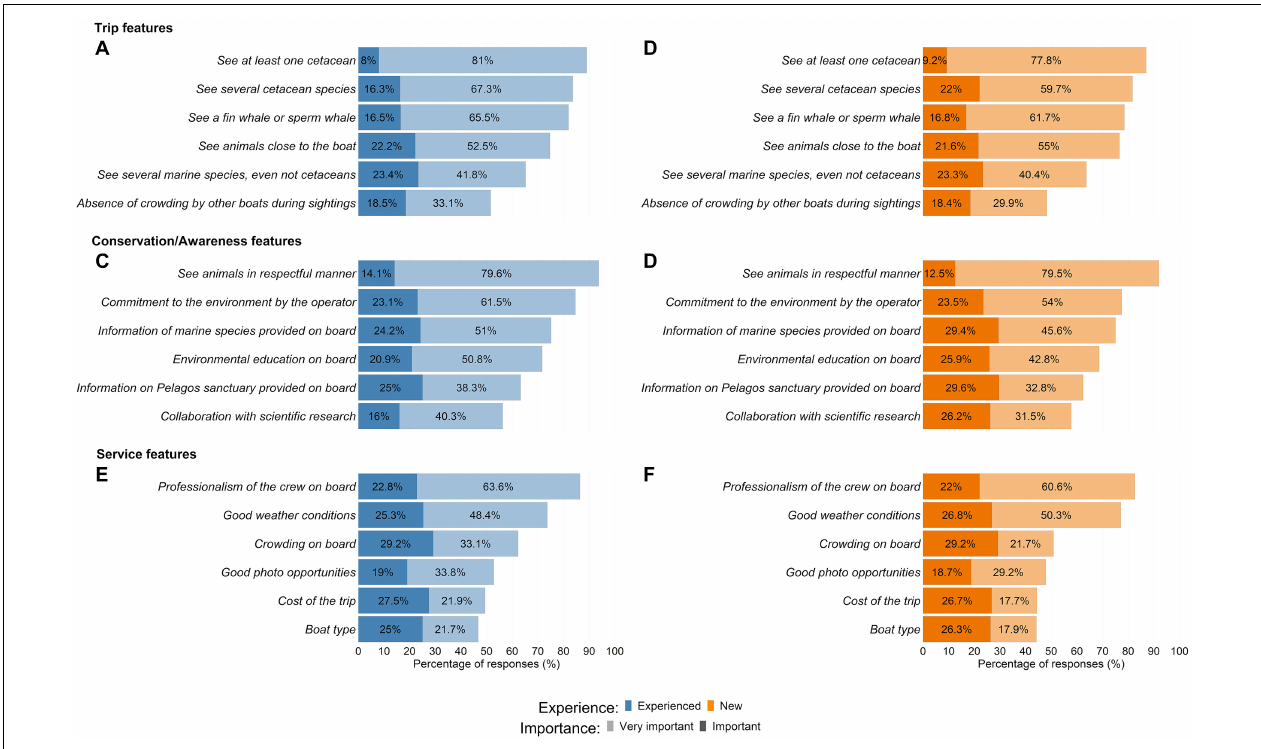
FIGURE 3 | Importance of trip (A,B) , conservation/awareness (C,D) and service (E,F) features for Experienced (blue) and New (orange) whale